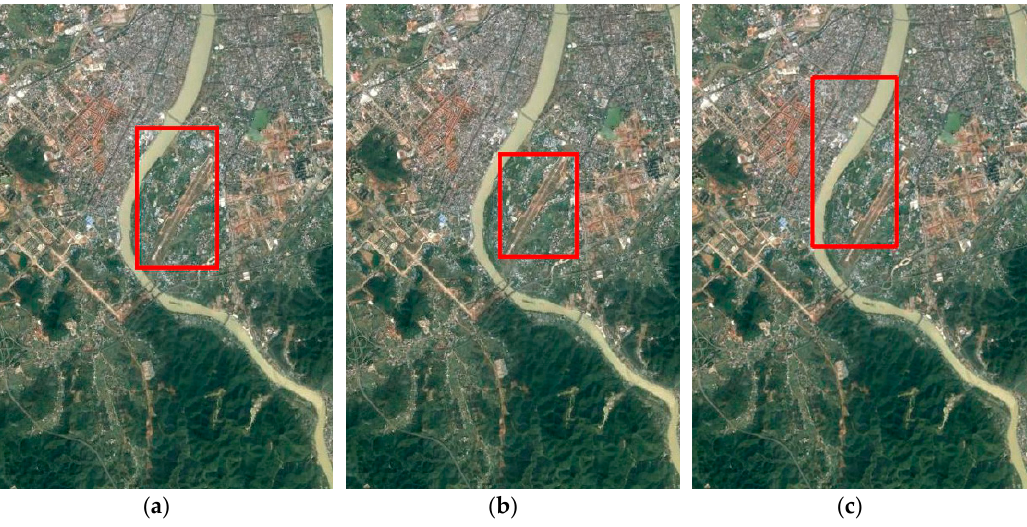
Figure 8. True detection results of different methods. ( a ) Faster R-CNN; ( b ) proposed method; ( c ) LSD + AlexNet. [Image courtesy of Google Earth].